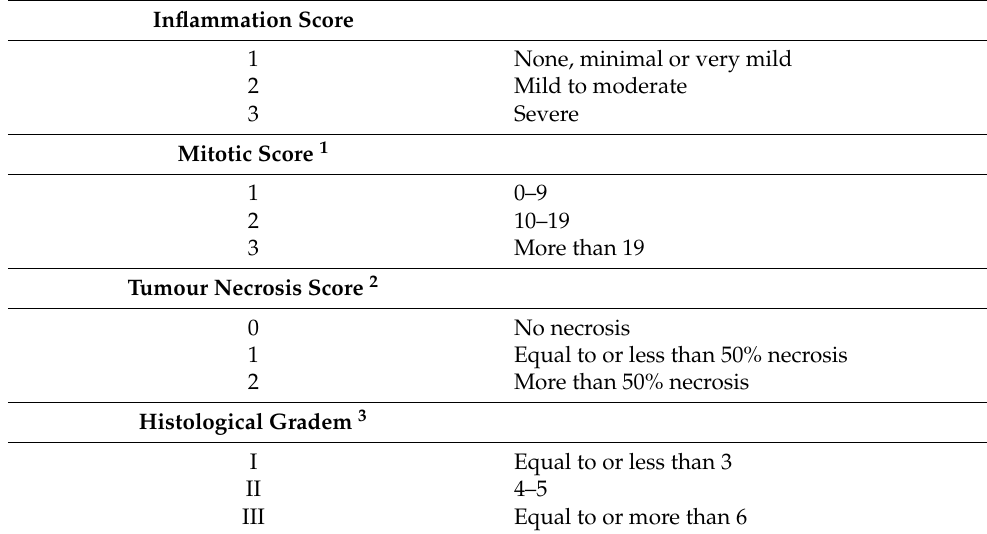
Table 2. Proposed grading system from feline cutaneous and subcutaneous soft tissue sarcomas